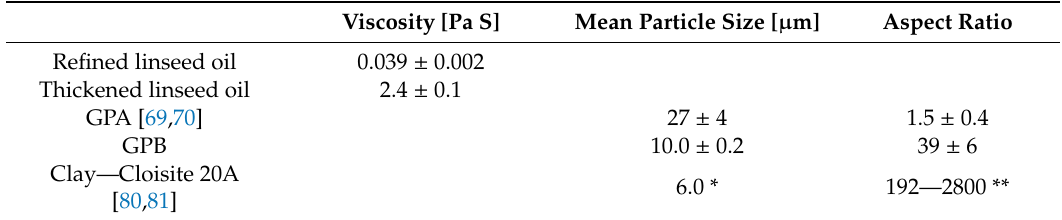
Table 1. Relevant properties of the materials: zero shear viscosity (at 0.1 Hz shear rate) of the matrix, mean particle size and aspect ratio (i.e., length divided by the width) of the